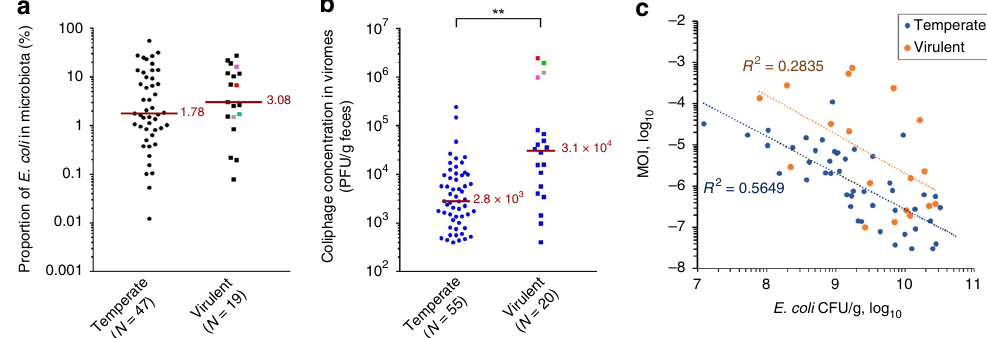
Fig. 2 E.coli and coliphage levels in microbiota, segregated by phage lifestyle. a A slight increase of the fraction of E. coli to total microbiota OTU is found among samples containing virulent coliphages, compared to those where temperate phages were found (not statistically signi fi cant, Mann – Whitney test, P = 0.39). b The overall coliphages titer in the fecal sample is signi fi cantly higher for virulent, compared to temperate phages (**, P = 0.0002). In both fi rst panels, red line = median value, four colored points = top coliphages titers. c The multiplicity of infection (MOI) correlates negatively with E. coli concentration in the fecal samples, both for virulent and temperate phage containing samples ( R 2 , coef fi cient of determination of the power law). Source data are provided as a Source Data fi